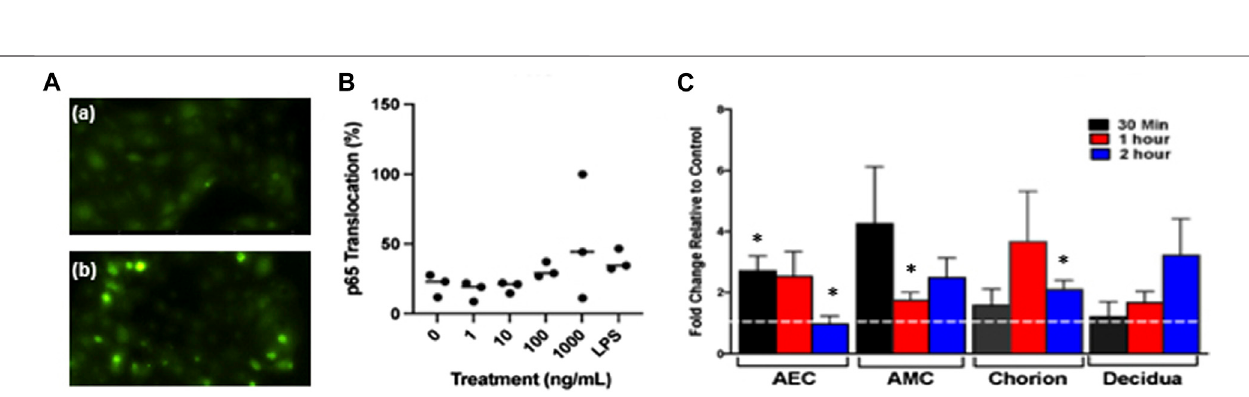
FIGURE2| FetalDNAcausesthetranslocationoftheNF- κ Bsubunitp65. (A) Immunocytochemistryofthenucleartranslocationofp65 (a) nottreatedwithcffDNA and (b) treated with 100 ng/ml of4 m.s. cffDNA. Green — p65. (B) Quantitation ofthe percentage of p65 translocation in AECs treated with 1, 10, 100, and 1,000 ng/ml 4 m.s. cffDNA or LPS 1000 ng/ml for 30 min n = 3 AEC from different patients ’ isolated cells. (C) Fetal membrane explants treated only apically with 100 ng/ml 4 m.s. cffDNA for 30 mins, 1, and 2 h. The dotted white line represents untreated control, AEC — amnion epithelial cells. AMC — amnion mesenchymal cells. The data displayed as fold change from no treatment control. ( n = 3 different patients ’ fetal membrane explants). * p = < 0.05.